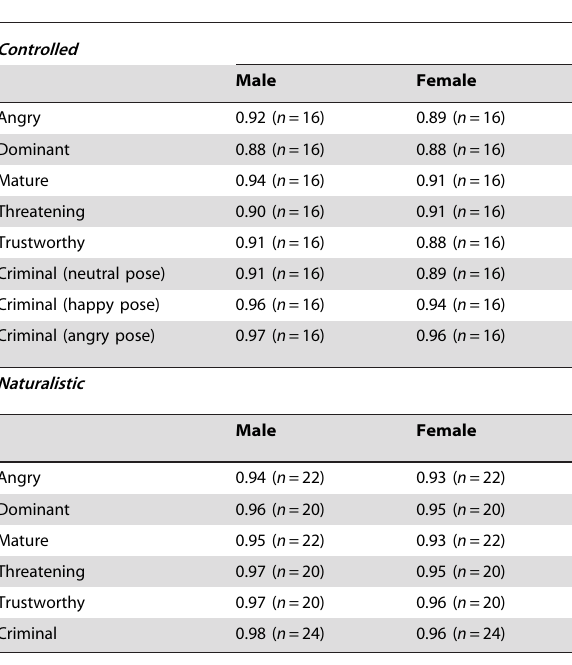
Table 1. Reliability (Cronbach’s a ) for Emotional State, Trait and Criminality Ratings for the Controlled and Naturalistic Photos by